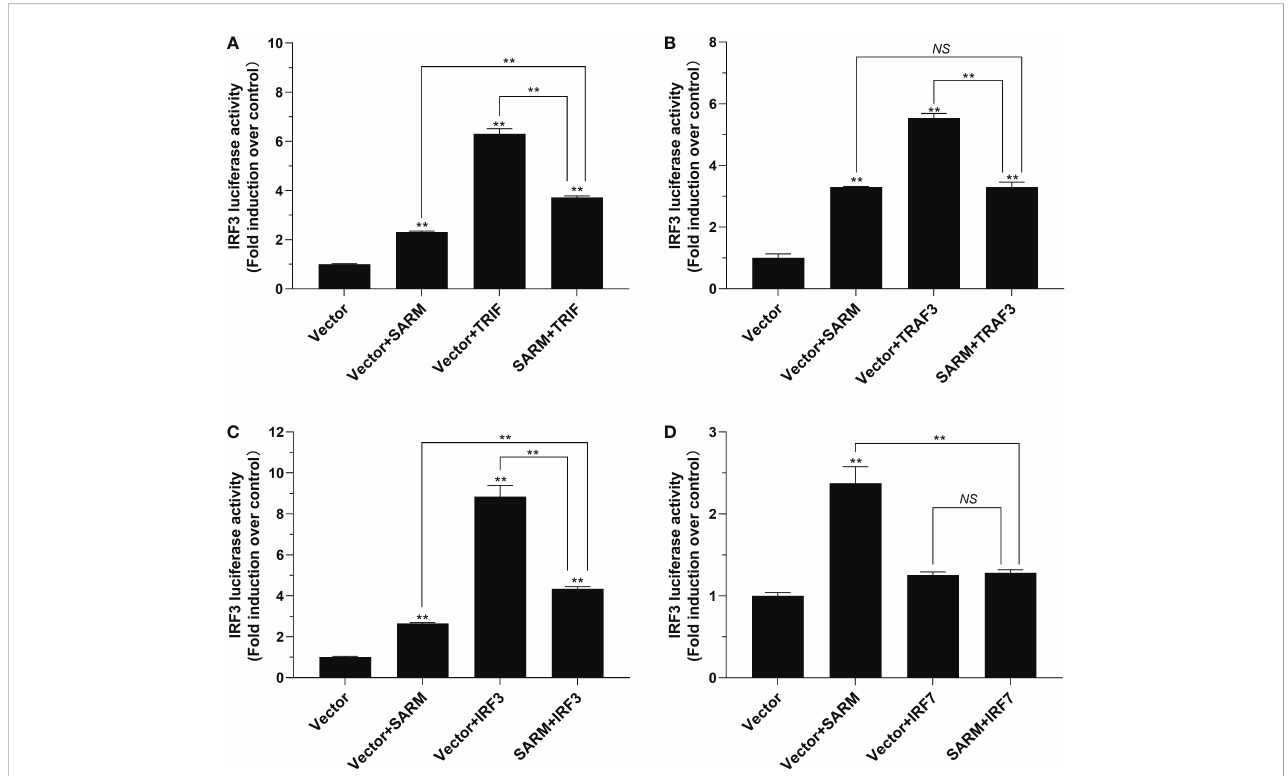
FIGURE 7 The role of Lc- SARM in the regulation of IRF3 signaling. The associations of Lc- SARM with Lc- TRIF (A) , Lc- TRAF3 (B) , Lc- IRF3 (C) and Lc- IRF7 (D) in the IRF3 promoter activation were analyzed by luciferase reporter assays. HEK 293T cells seeded in 24-well plates (1 × 10 5 cells/well) were co-transfected with 100 ng of pGL4-IRF3-pro and 10 ng of pRL-TK together with 100 ng of pcDNA3.1-SARM, pcDNA3.1-TRIF, pcDNA3.1-TRAF3, pcDNA3.1-IRF3, and pcDNA3.1-IRF7 alone or in a combination of two as described above. The cells were harvested at 24 hpt and used for the measurement of luciferase activities. All data are expressed as mean of three independent experiments, with bars representing the SE. * P < 0.05; ** P < 0.01; NS, not signi fi